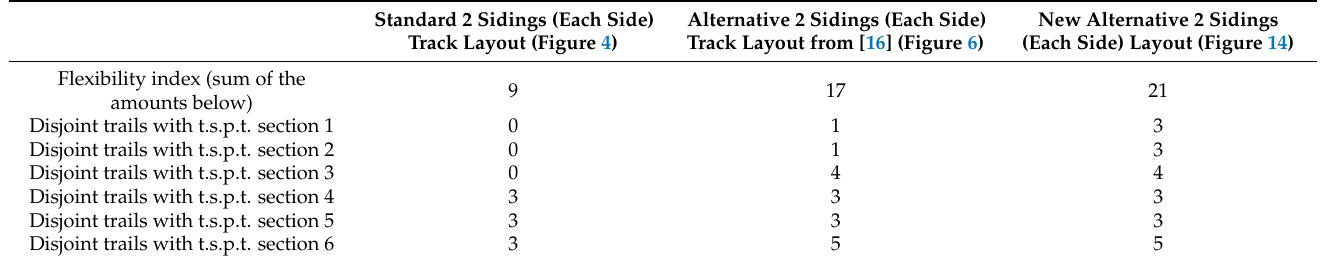
Table 1. Comparison of alternative trails in the different track layouts. The acronym “t.s.p.t.” means here “the shortest path